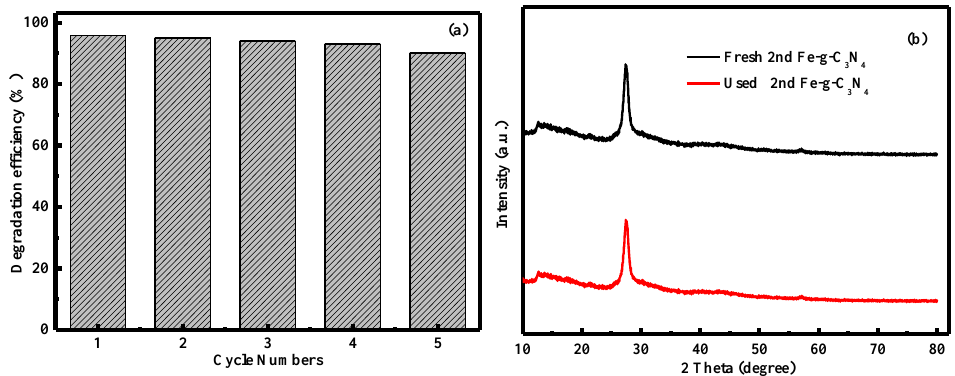
Figure 5. Reusability of the 2 nd Fe–g–C 3 N 4 after five cycles ( a ); XRD patterns of the fresh and used 2 nd Fe–g–C 3 N 4 ( b ).